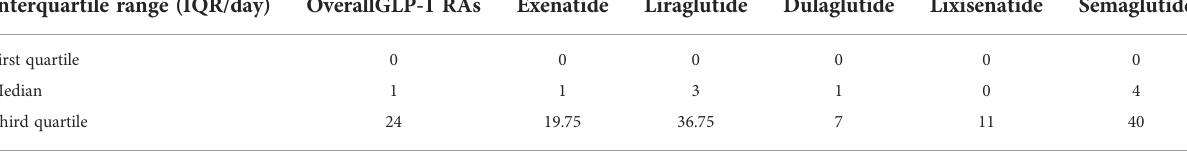
TABLE 4 Time-to-onset of GLP-1 RA-associated gastrointestinal AEs. Interquartile range